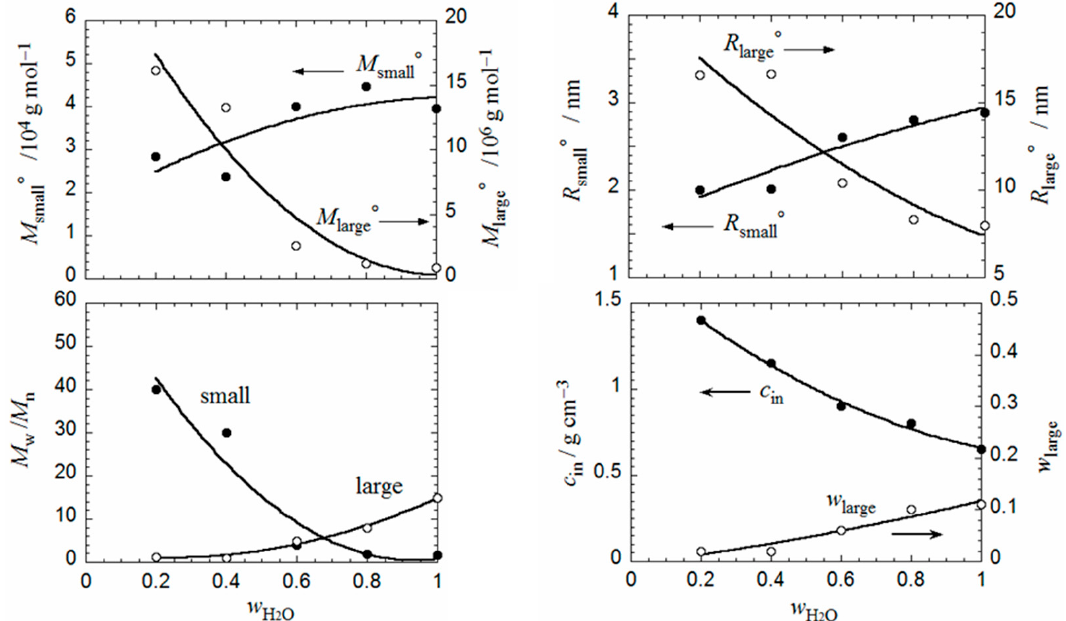
Figure 6. Solvent composition dependences of parameters for PFSI spherical particles determined by fitting of SAXS profiles shown in Figure 5b.